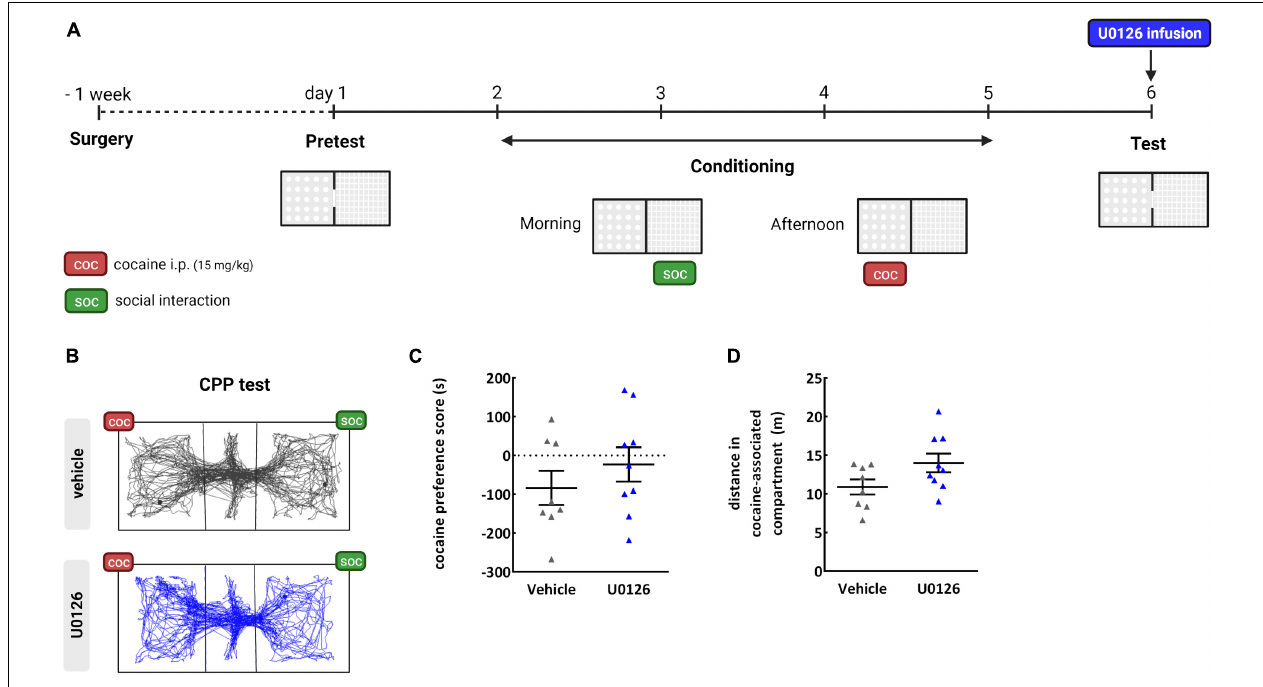
FIGURE 2 | Inhibition of ERK in the NAc by a bilateral infusion of U0126; (A) timeline; (B) representative tracking of rats receiving cocaine injections in one compartment and the opportunity of SI with a partner in the opposite compartment, after vehicle or bilateral U0126 intra-NAc infusions. (C) Cocaine preference score in a concurrent paradigm in which rats were conditioned to cocaine at the dose of 15 mg/kg and to SI in the opposite compartment. Intra-NAc U0126 bilateral infusions before the CPP test did not affect cocaine preference; (D) distance in cocaine-associated compartment during the test after U0126 infusions was trending to increase ( p = 0.07) without reaching significance as compared to vehicle-infused rats, n =